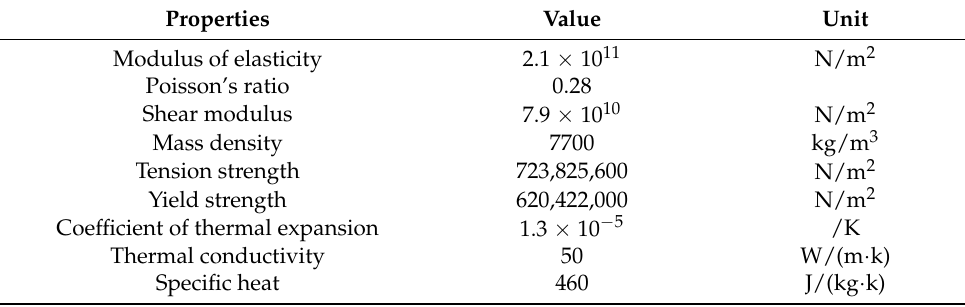
Table 3. Physical properties of alloy steel